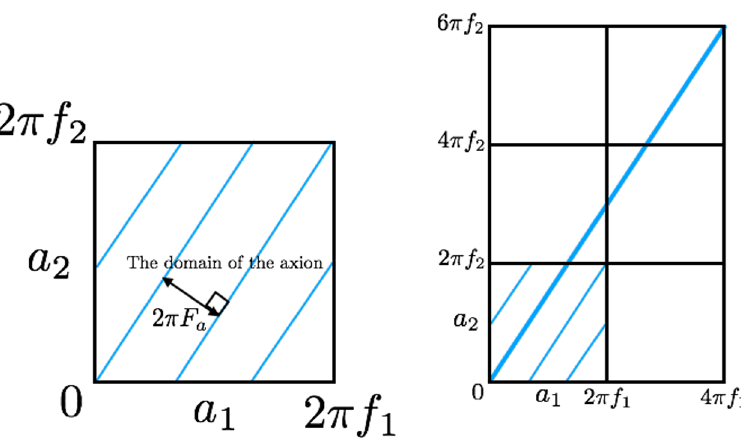
Figure 1 . (Left) A gauge orbit in the domain of ( a 1 ; a 2 ) for j q j = 10 ; j q 0 j = 15. (Right) The unwound gauge